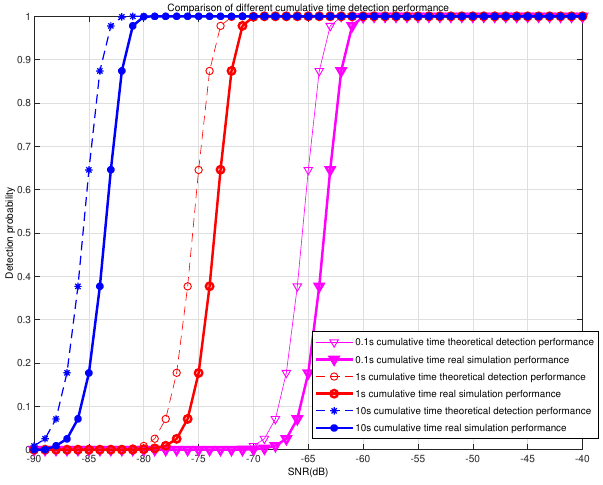
Figure 16. Influence of different accumulation time on detection